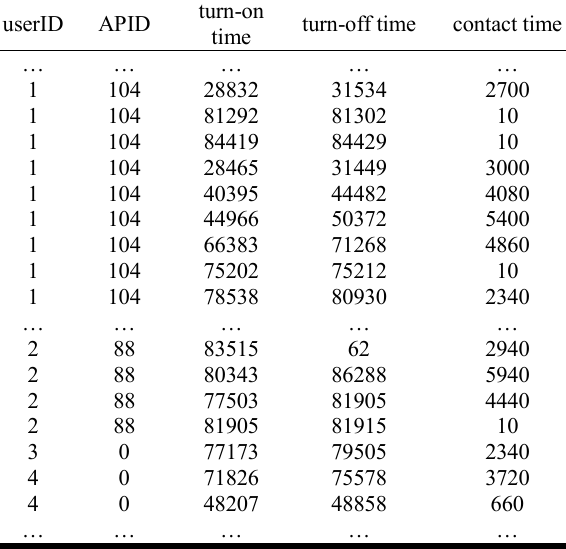
Table 1. Part of records of user contacts.